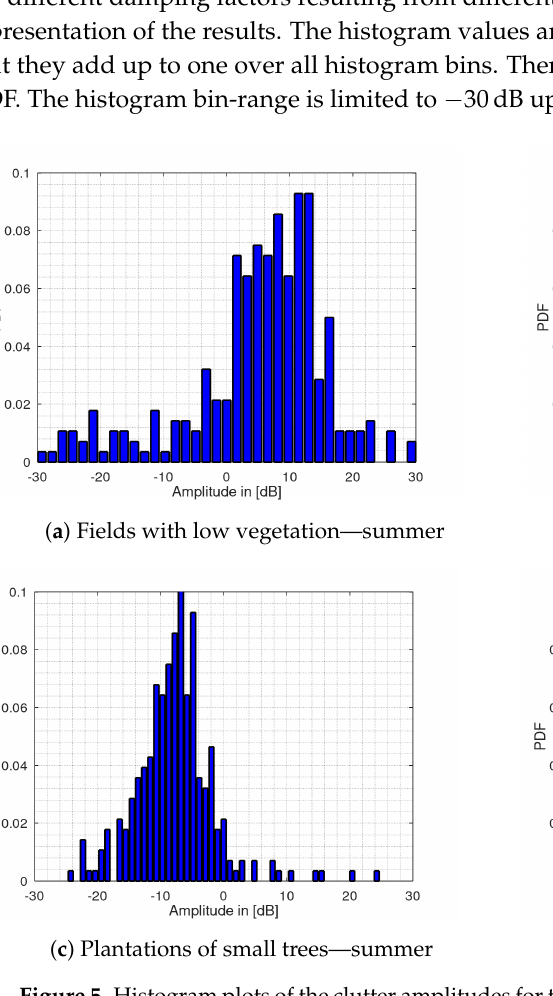
Figure 5. Histogram plots of the clutter amplitudes for the summer measurements for ( a ) fields with low vegetation, ( b ) fields with high vegetation, ( c ) plantations of small tress and ( d ) forest